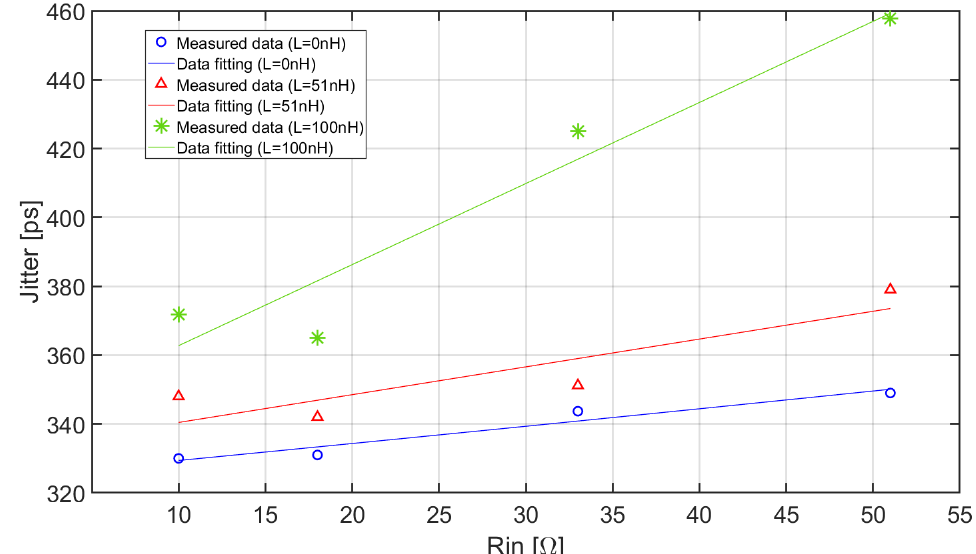
Figure 17. Time jitter as a function of R in and L. The light continuous curves are first order exponential fittings of the measured data points.